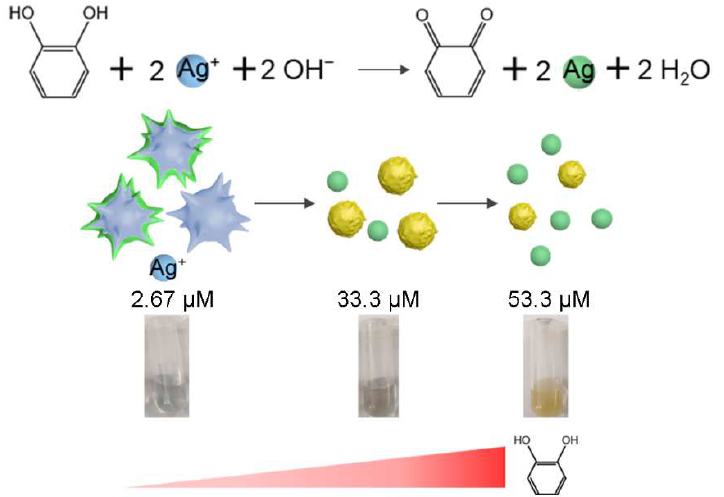
Figure 3. The mechanism of LSPR-based chemical sensor in CC-mediated plasmonic effect on the Au NSs.